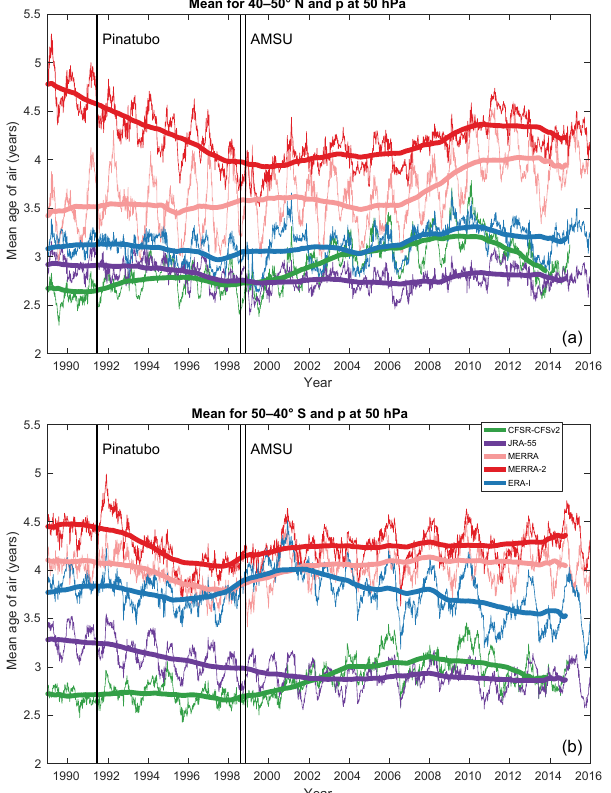
Figure 6. Time evolution of AoA (years) interpolated to a pressure of 50hPa in the northern midlatitudes (40–50 ◦ N mean, a ) and in the southern midlatitudes (50–40 ◦ S mean, b ). Thin lines show instan- taneous model output every 5 days using the five reanalyses with color codes according the legend shown in the lower panel. Thick lines are smoothed with a 1-year running mean. The black vertical lines highlight the start of the Pinatubo eruption and the first assim- ilation of AMSU (see text).